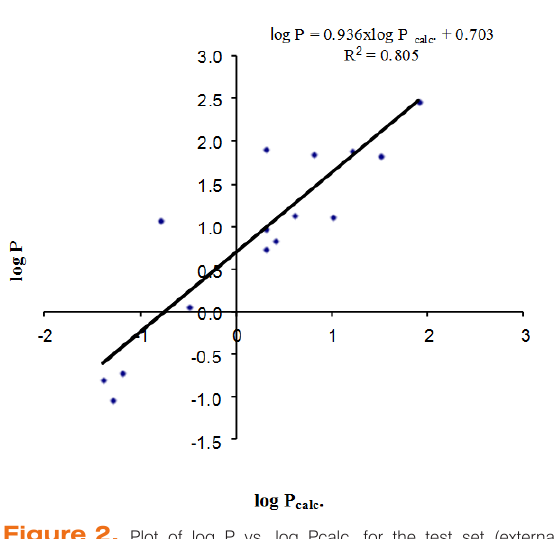
Figure 2. Plot of log P vs. log Pcalc. for the test set (external